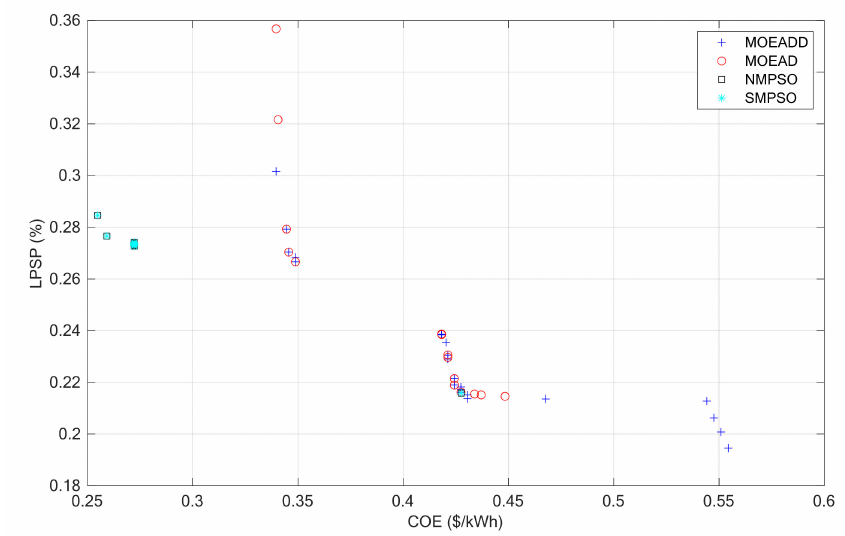
Figure 10. Comparison of PFs obtained for CASE 1 using different algorithms.